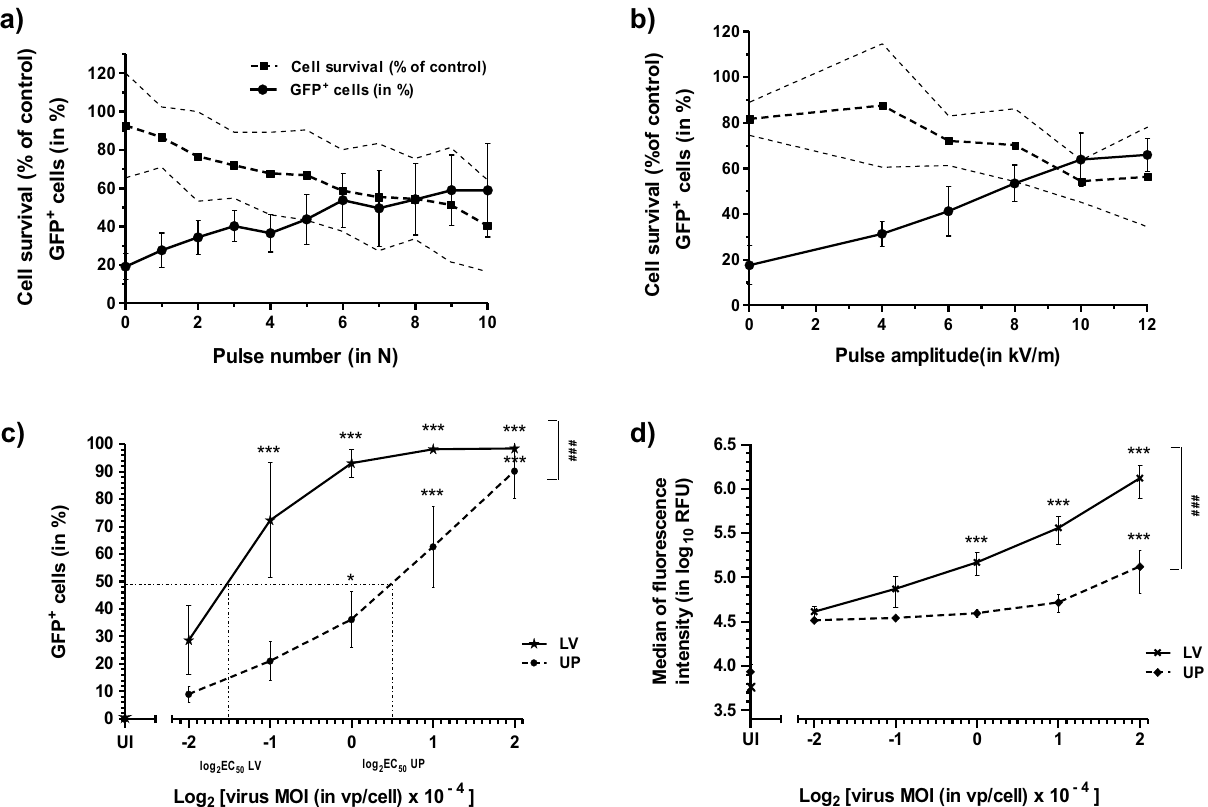
Figure 2. Influence of various experimental parameters on GFP gene expression and survival of L929 cells subjected to adenovirus infection and LV pulse application. GFP + cells (in %) and cell survival (in % of UI/ UP cells) as a function of: ( a ) the number (in N) of LV pulses delivered, ( b ) the amplitude of LV pulses (in kVm −1 ). Infected L929 cells (MOI = 10 4 vp/cell) were subjected to ( a ) increasing numbers of LV pulses at 12 kVm −1 , or ( b ) ten LV pulses of increasing voltages up to 12 kVm −1 , 48 h prior to flow cytometry. Abbreviations and curve symbols for ( a , b ) graphs: GFP + cell % (black filled circle), with error bars, cell survival (black filled square), with error (thin dotted lines). Data are presented as means ± SD (with n ( a ) = 5 and n ( b ) = 3). ( c ) GFP + cells (in %) and ( d ) median of fluorescence intensity (in log 10 RFU), as a function of the viral MOI used for infection (half dilutions from 4 × 10 4 to 0.25 × 10 4 vp/cell were converted into a log 2 for graphic considerations). L929 cells were mixed with rAd or with the vehicle alone (UI condition) and left unpulsed (UP condition) or subjected to LV pulses and analyzed by flow cytometry, 27 h post treatment. In ( c ), half maximal effective virus concentrations (EC 50 ) for LV and UP conditions have been indicated. Abbreviations and curve symbols for ( c,d ) graphs: UI uninfected, UP unpulsed, LV low voltage pulses; GFP + cell % when UP (black filled circle) or after LV (black filled star), and median of fluorescence intensity when UP (black filled diamond) or after LV (black filled cross). Data are presented as means ± SD (with n = 4 for ( c,d ) ). Statistical significances for ( c,d ): * p < 0.05 and *** p < 0.001 stand for intra-curve comparisons of GFP + cells and fluorescence intensity versus the lowest MOI condition; ### p < 0.001 for UP and LV curve comparison (two-way ANOVA with Bonferroni’s post-test for ( c ), two-way ANOVA on ranks with Tukey post-test for ( d